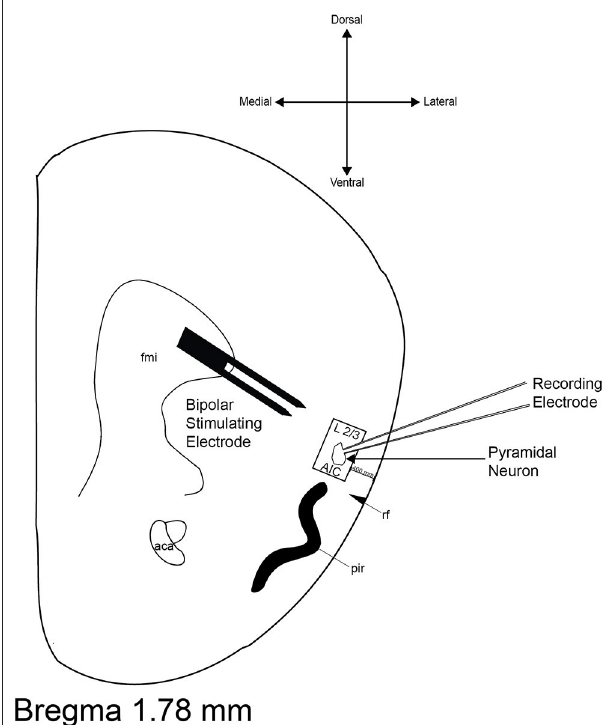
FIGURE 1 | Representative diagram of recording site and bipolar stimulating electrode placement. The boundaries of the area from which neurons were selected for recordings are inside the black box. The boundaries of the stimulating electrode are located ≈ 500 µ m dorsomedial to the recording electrode. aca, anterior commissure; AIC, agranular insular cortex; fmi, forceps minor of the corpus callosum; pir, piriform cortex; rf, rhinal